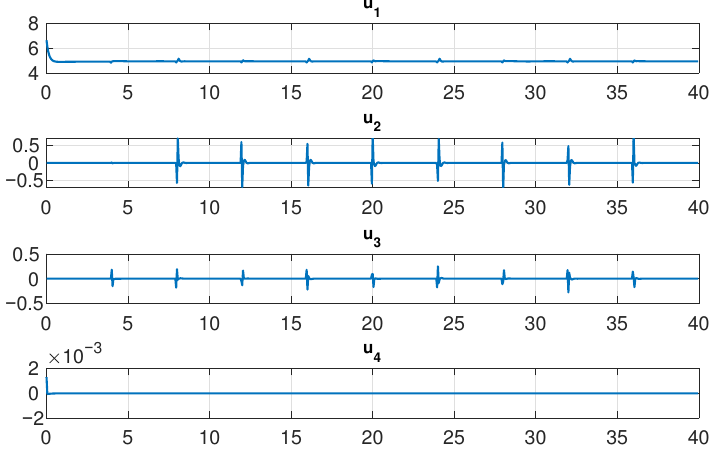
Figure 22. Signal response ( u 1 , u 2 , u 3 , u 4 ) from PID controller optimized with 100 individuals.